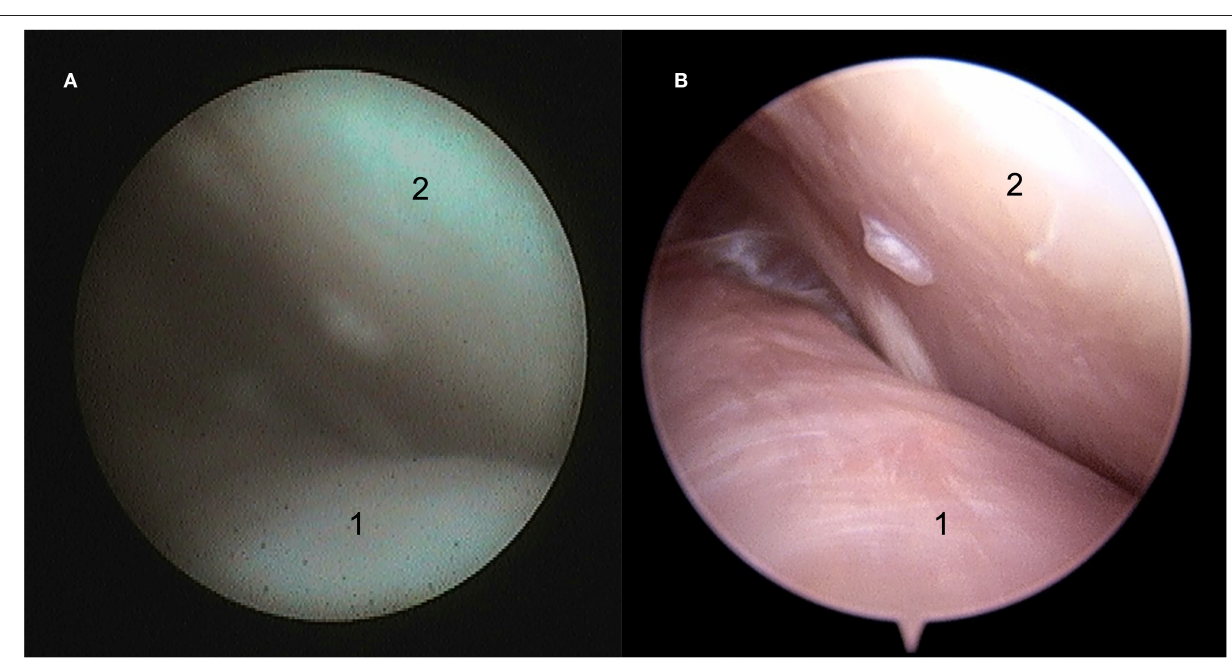
10 ◦ and 30 ◦ FVA became apparent ( Figure 3 ), especially as the authors elected to only access the caudal aspect of the joint compartments in the cadaver heads. While the flexibility of the